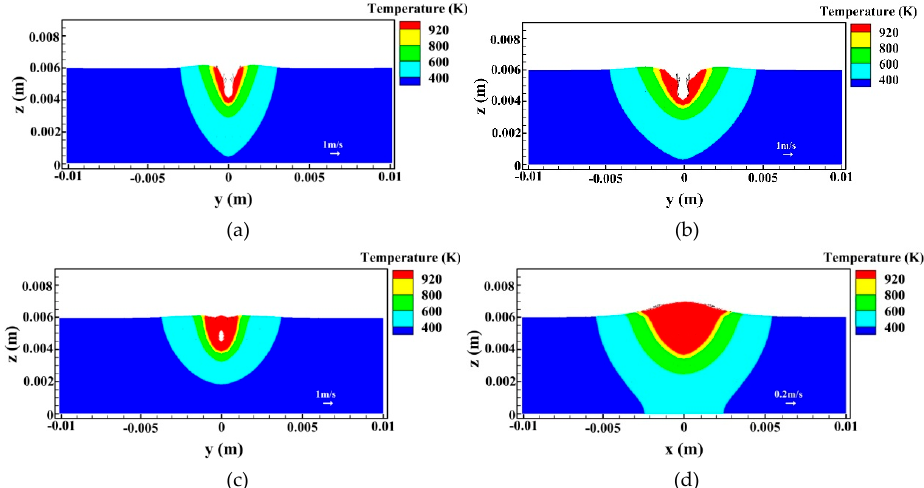
Figure 12. Temperature and velocity fields on the cross section for I = 200 A ( x = 20 mm): ( a ) t = 0.92 s, ( b ) t = 0.93 s, ( c ) t = 0.94 s, and ( d ) t = 1.12 s.